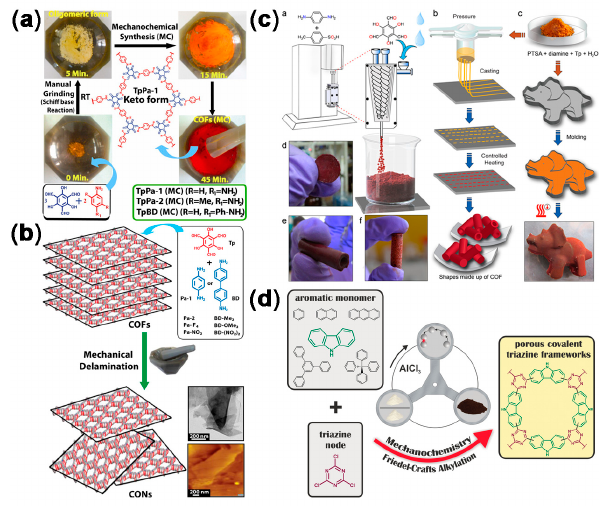
Figure 4. Schematic representations of mechanochemical synthesis. ( a ) Manual grinding to